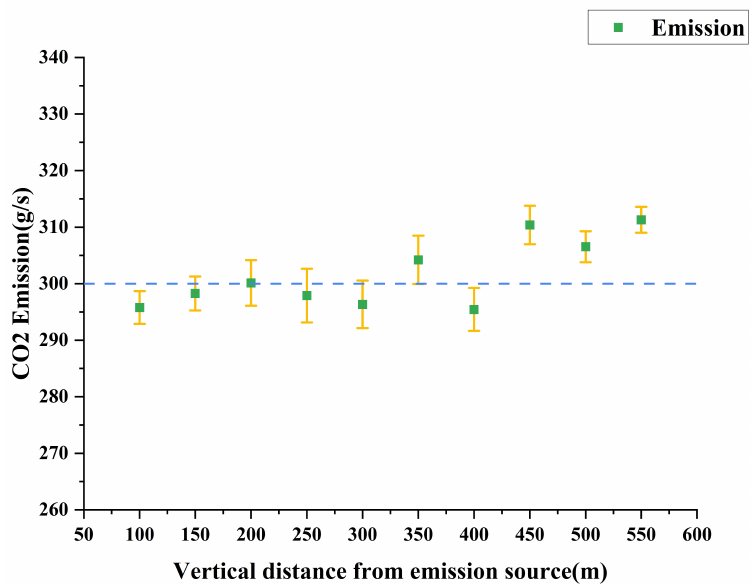
Figure 7. CO 2 emission retrieval results under different measurement